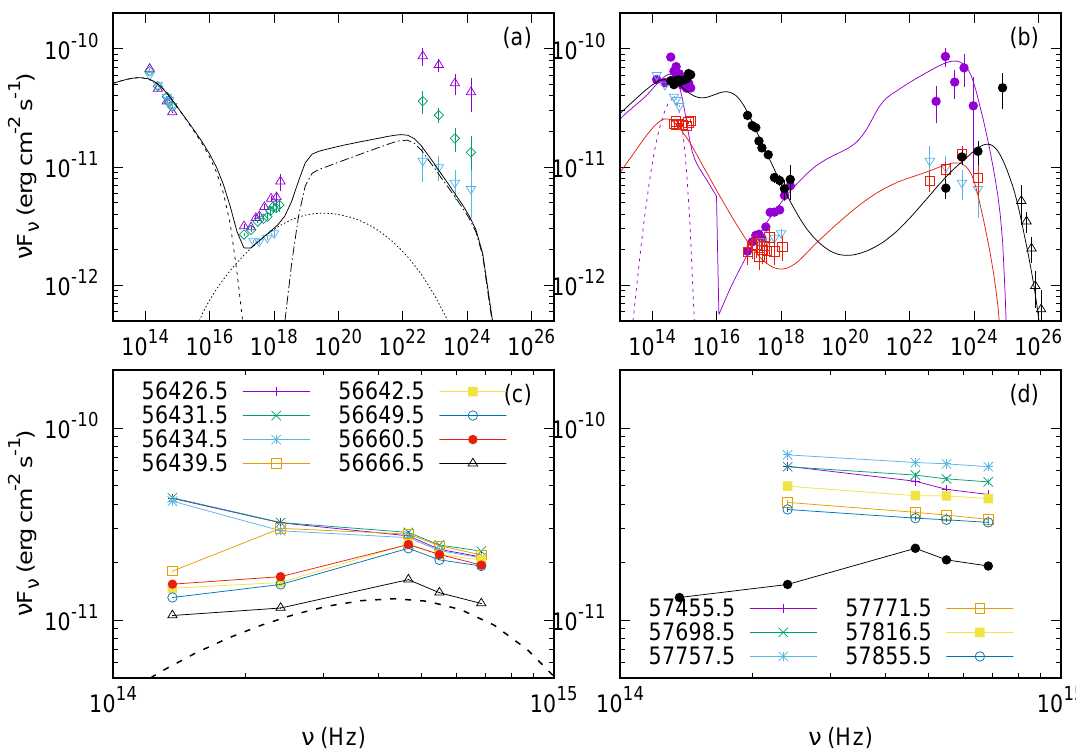
Figure 1. Broadband and optical SEDs showing the spectral phases exhibited by OJ 287 to date. ( a ) Typical broadband SEDs of OJ 287 from a 2009 observation [28] showing three different flux states: Flare (magenta, MJD: 55124-55131), moderate (green, MJD: 55131-55152) and quiescent (cyan, MJD: 55152-55184) MW emission. The solid curve is the total emission with synchrotron, SSC and EC-IR component shown respectively in dashed, dotted, and dot-dashed curves (see [28], for modeling details). ( b ) Broadband SEDs of the source in its new spectral phase during 2016–2017 with magenta (MJD: 57359-57363; [60]) showing a flare SED, black (MJD: 57786; [27]) showing a typical SED during the VHE phase and red (MJD: 57871; [27]) showing the quiescent SED state after the VHE activity with the lowest flux across EM spectrum. For reference/comparison, the quiescent SED (cyan) from panel ( a ) is also shown. The solid curves are the model produced spectrum (see [27,60], for details), while the dotted curve is the standard accretion-disk spectrum of a ∼ 10 10 M (cid:12) SMBH; ( c ) NIR-optical spectrum highlighting the timing of tbe appearance of spectral break [60]. The dashed curve is the accretion-disk spectrum drawn again for clarity. ( d ) NIR-optical SEDs before (MJD 57455.5), during and after the VHE activity of OJ 287, showing return to the typical power-law NIR-optical spectrum. For comparison, one of the SED (black) from ( c ) is also